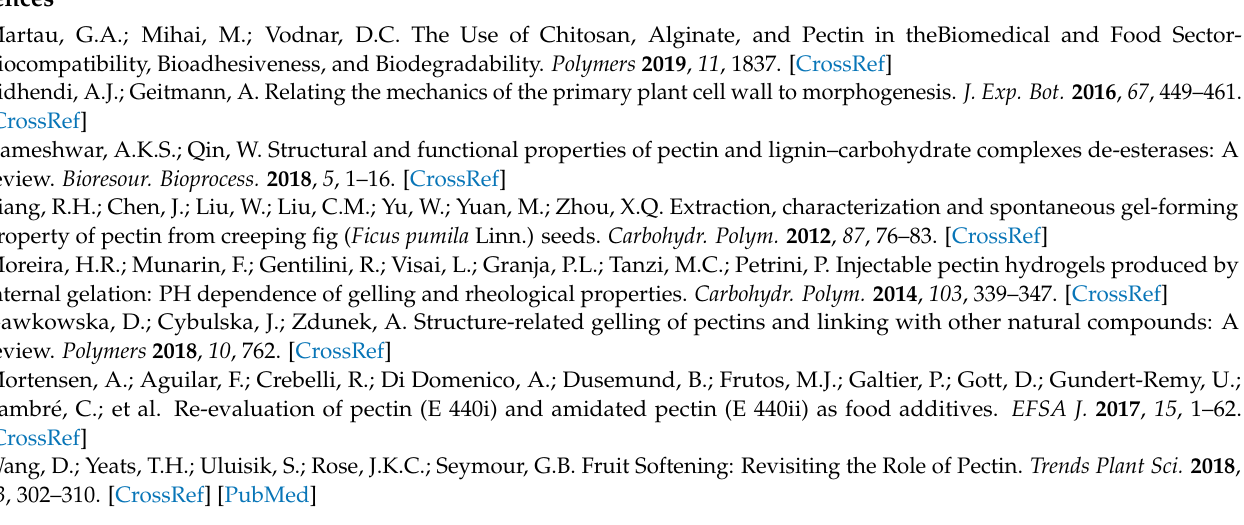
Figure S2: FTIR spectra of formulation F3, its physical mixture, and F8, Figure S3: FTIR spectra of formulation F4, its physical mixture, and F9, Figure S4: FTIR spectra of formulation F5, its physical mixture, and F10, Figure S5: The thermogram of formulation F1 (red line), F6 (blue line), and the physical mixture of F1 (black line) as well as the curve of PVAC-D (green line), Figure S6: The thermogram of formulation F2 (red line), F7 (blue line), and the physical mixture of F2 (black line), Figure S7: The thermogram of formulation F3 (red line), F8 (blue line), and the physical mixture of F3 (black line), Figure S8: The thermogram of formulation F4 (red line), F9 (blue line), and the physical mixture of F4 (black line), Figure S9: The thermogram of formulation F5 (red line), F10 (blue line), and the physical mixture of Figure 5 (black line), Table S1: The DSC endotherms and exotherms ( ↓ ) of formulations F1–F10 and the corresponding physical mixtures (M). The listed numbers refer to the value of